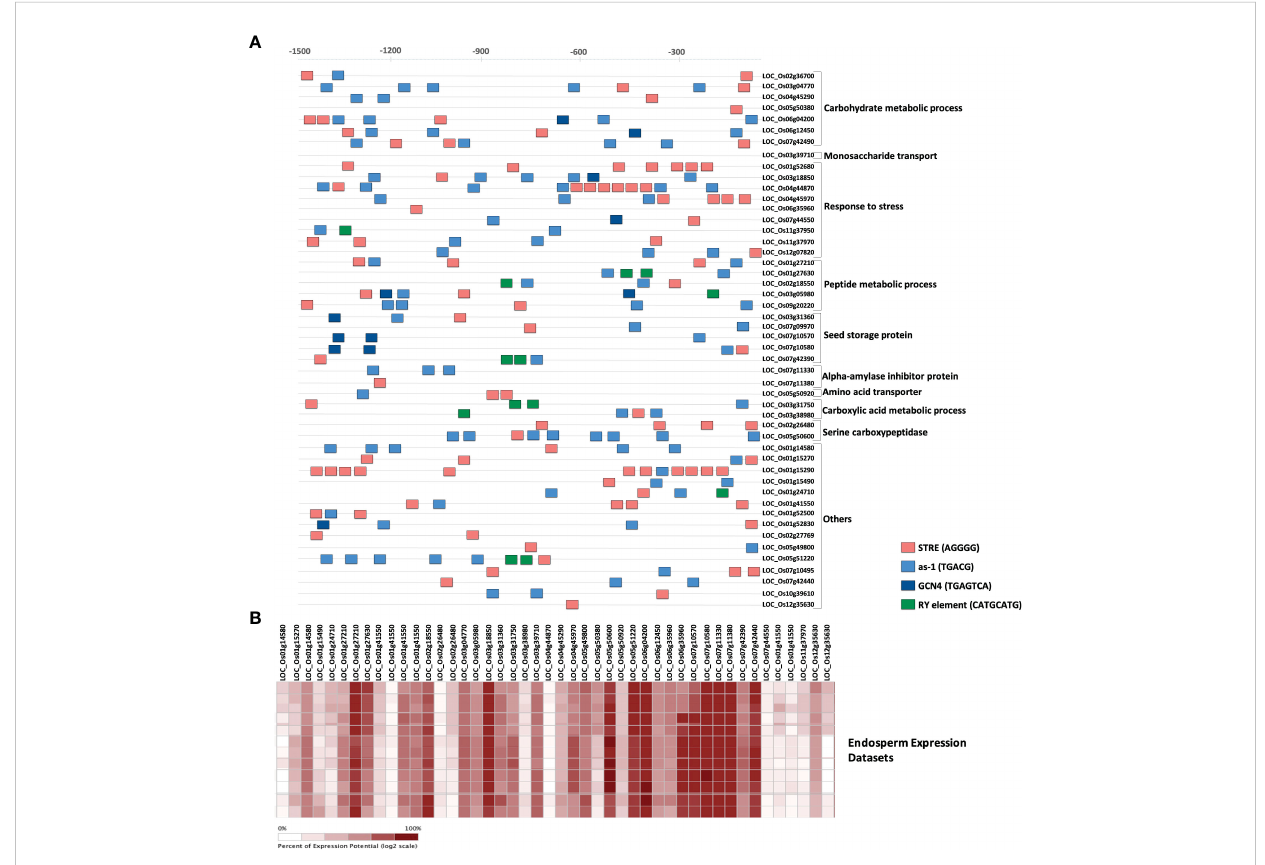
FIGURE 4 Spatio-temporal expression of candidate genes. (A) In silico identi fi cation of regulatory elements in the putative promoter region of the identi fi ed fundamental set and known chalk-responsive genes. Coloured boxes indicate as-1 element (blue), RY element (green), STRE (salmon) and GCN4 motif (dark blue) in 1500 bp upstream promoter regions. Scale is presented above the fi gure. (B) Heatmap highlighting the percent expression pattern of candidate genes in the endosperm, fi gure created using